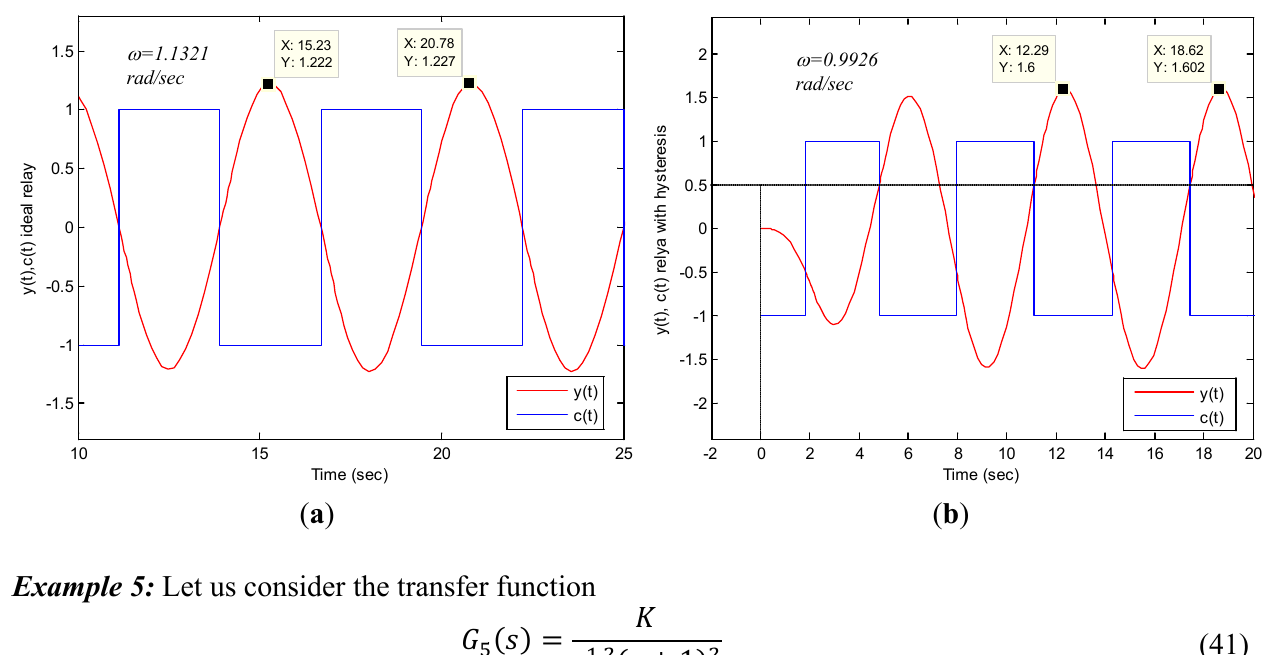
( a ) ideal relay 𝐺 4 (𝑗𝜔)